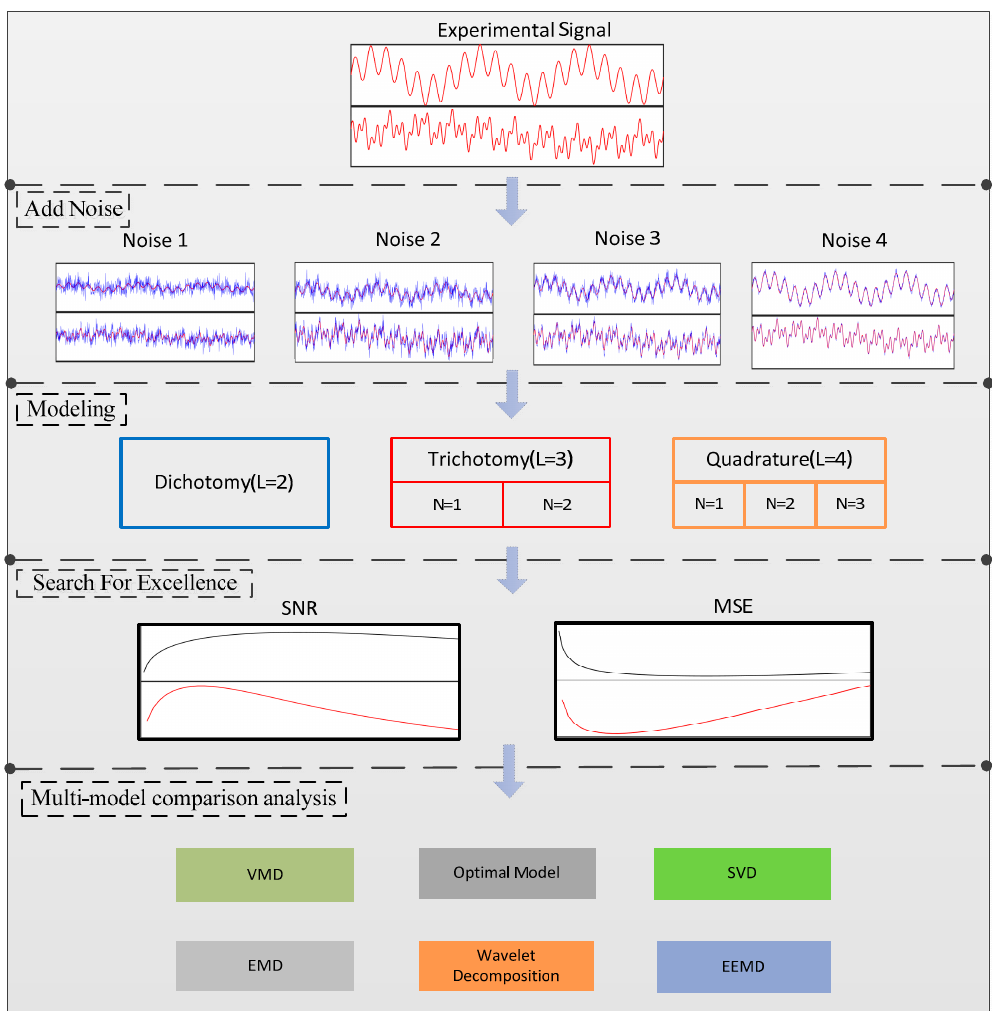
Figure A1. Model flow chart.